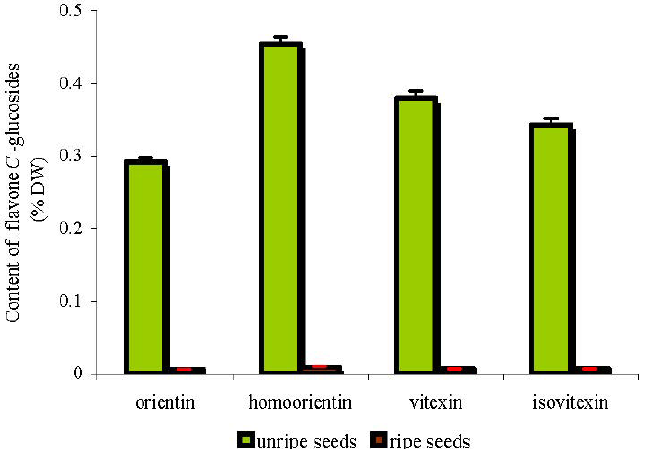
Figure 2. The content of flavone C -glucosides in the unripe and ripe seeds of common buckwheat harvested at 48 and 100 DAS, respectively (%